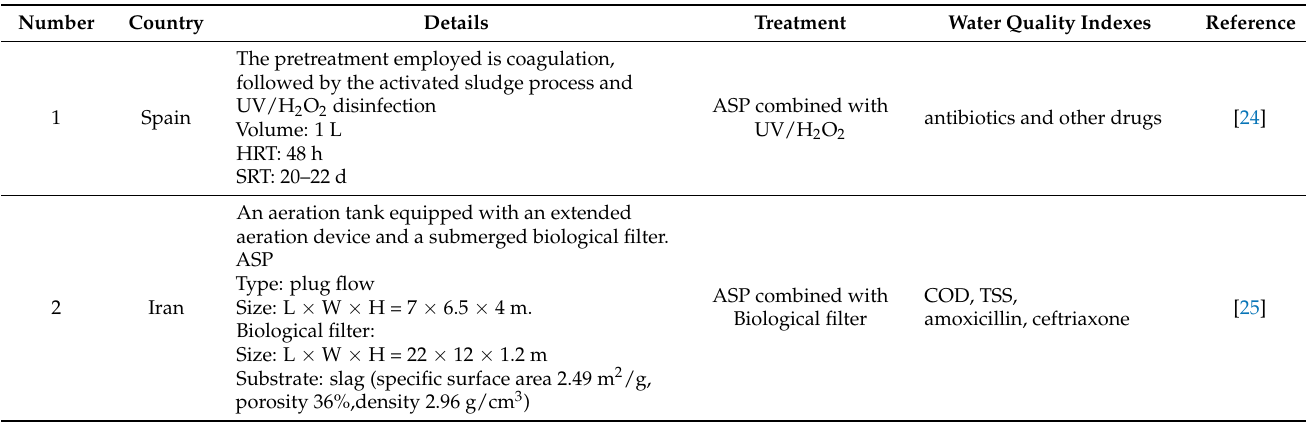
Table 2. Traditional treatment, advanced technology, and application of CWs in hospital wastewater